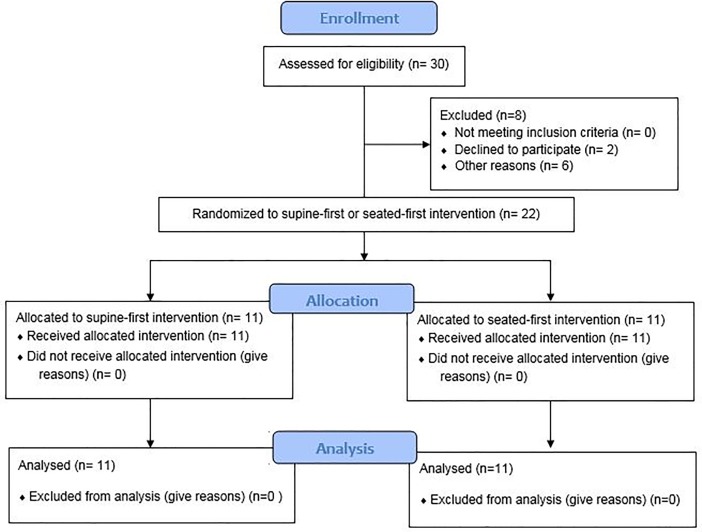
Consort statement.